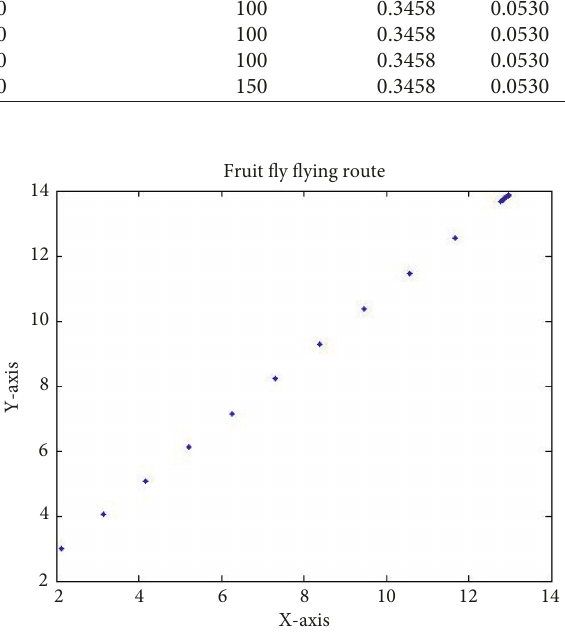
Figure 5: IFOA-GRNN fruit fly search